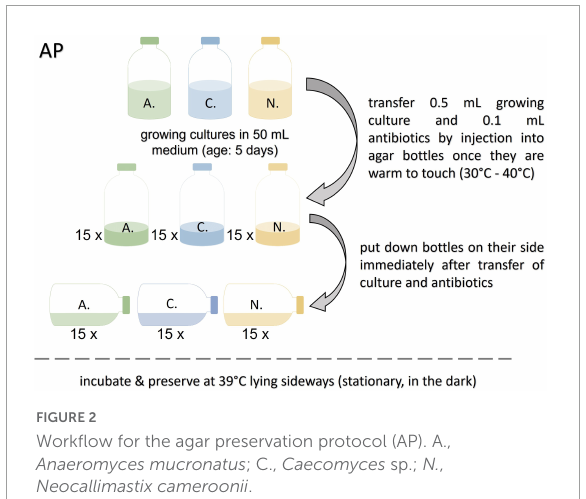
best growth were chosen per strain and injected with 1 mL pre- cooled ethylene glycol stock solution each. The glass vials were put on ice for 10 min and then transferred to – 20 ◦ C for 1 h. They were stored at – 80 ◦ C until resuscitation (see Figure 3 ). This protocol was based in part on the method reported by Nagpal et al.